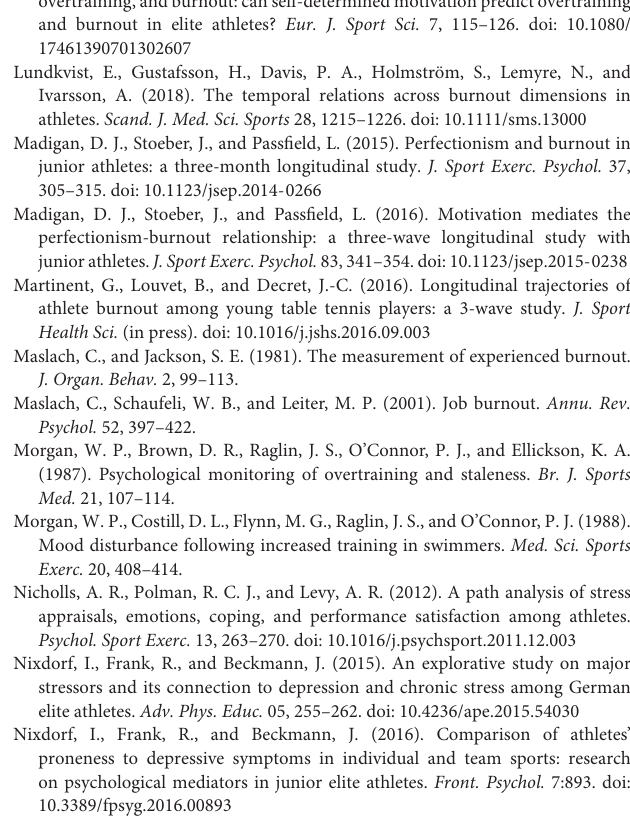
junior athletes: a three-month longitudinal study. J. Sport Exerc. Psychol. 37, 305–315. doi: 10.1123/jsep.2014-0266